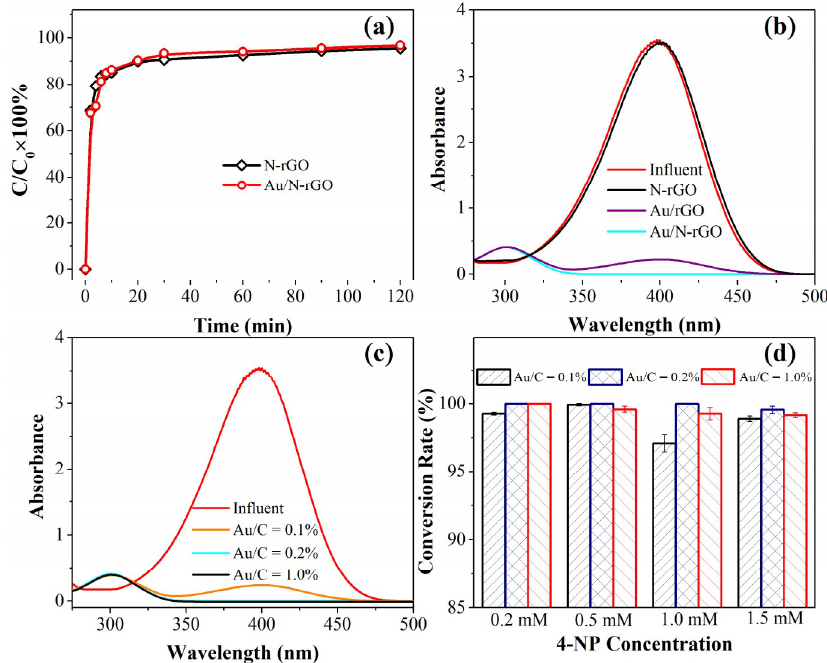
Figure 4. ( a ) Breakthrough curves of the N-rGO filter and the Au/N-rGO filter; ( b ) UV-Vis absorption spectra before and after passing through the N-rGO filter, the Au/rGO filter, and the Au/N-rGO filter; ( c ) effect of Au loading amount on 4-NP conversion by the Au/N-rGO filters, where the Au/C ratio is 0.1%, 0.2%, and 1.0%; ( d ) the 4-NP conversion as a function of Au loading and 4-NP concentration.